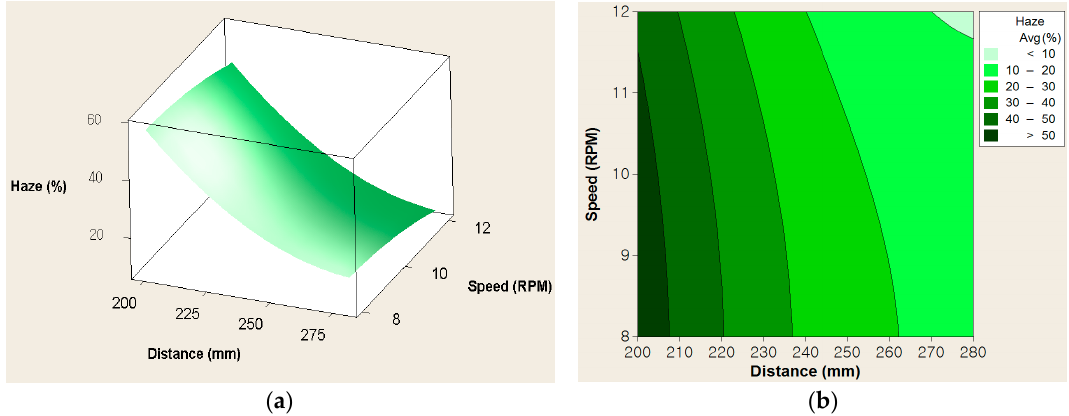
Figure 3. Effects of the distance of the nozzle from the surface and the motor speed for control of glass feed speed on the haze (the pressure of nozzle was held at 3.5 Mpa: ( a ) 3D surface plot; ( b ) contour